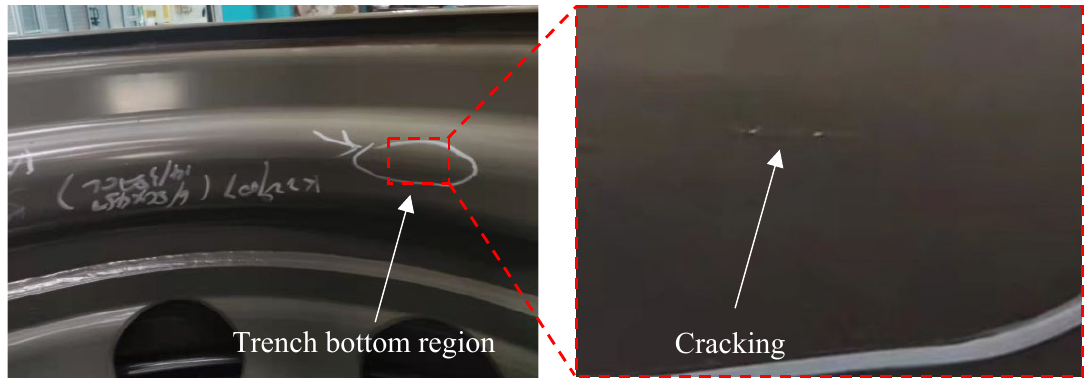
Figure 17. Rim fatigue failure location.